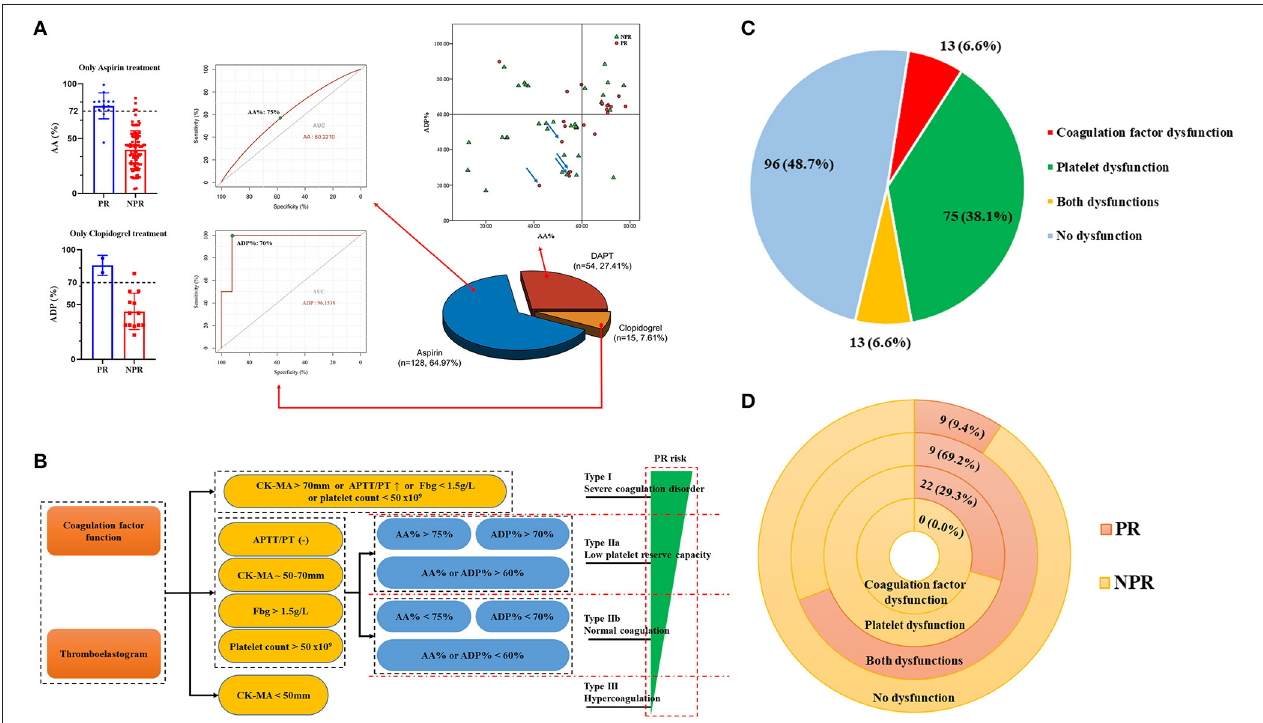
FIGURE 2 | Preoperative platelet function and novel coagulation classification. (A) The AA% at 75% for patients receiving aspirin only, the ADP% at 70% for patients receiving clopidogrel only, the AA%/ADP% at 60% for patients receiving DAPT could discriminate patients with PR from patients with NPR. (B) This classification categorized all patients into four types: Type I, patients having platelet count ↓ , platelet hypofunction, or coagulation factor dysfunction; Type IIa, patients having normal platelet count, normal platelet and coagulation factor function, and AA%/ADP% ↑ ; Type IIb, patients having normal platelet count, normal platelet and coagulation factor function, and no AA%/ADP% ↑ ; Type III, patients having platelet hyperfunction. (C) The characteristics of preoperative coagulation disorder. (D) The incident rate of PR in different coagulation disorders. PR, postoperative rebleeding; NPR, no postoperative rebleeding; DAPT, dual antiplatelet therapy; AA%,